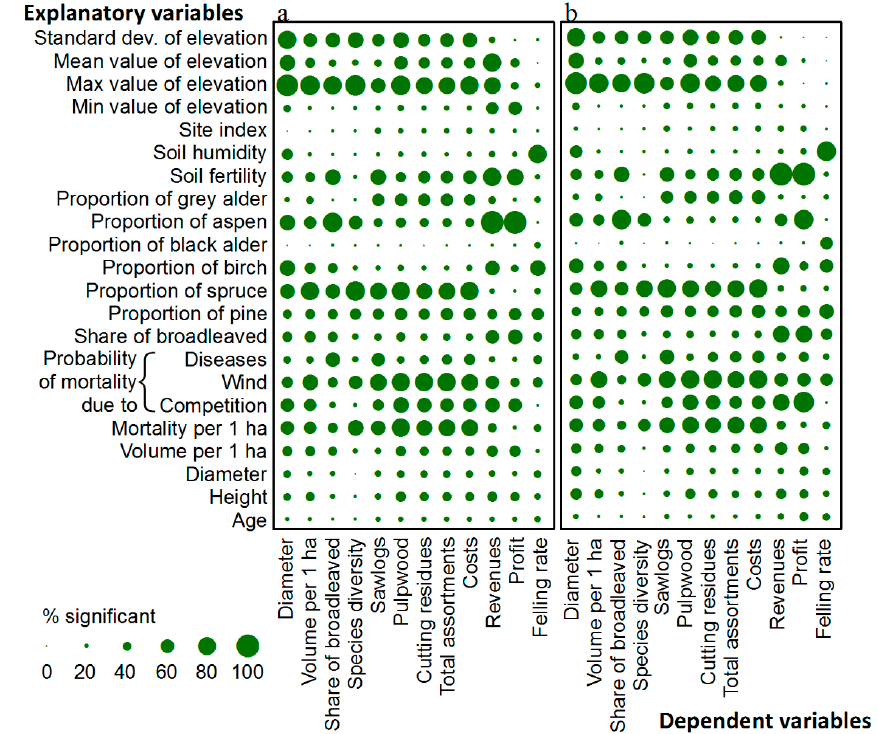
Figure 12. The proportions of times that each candidate explanatory variable was statistically significant when testing all potential regression models: ( a ) REFERENCE scenario, ( b ) EU BIOENERGY